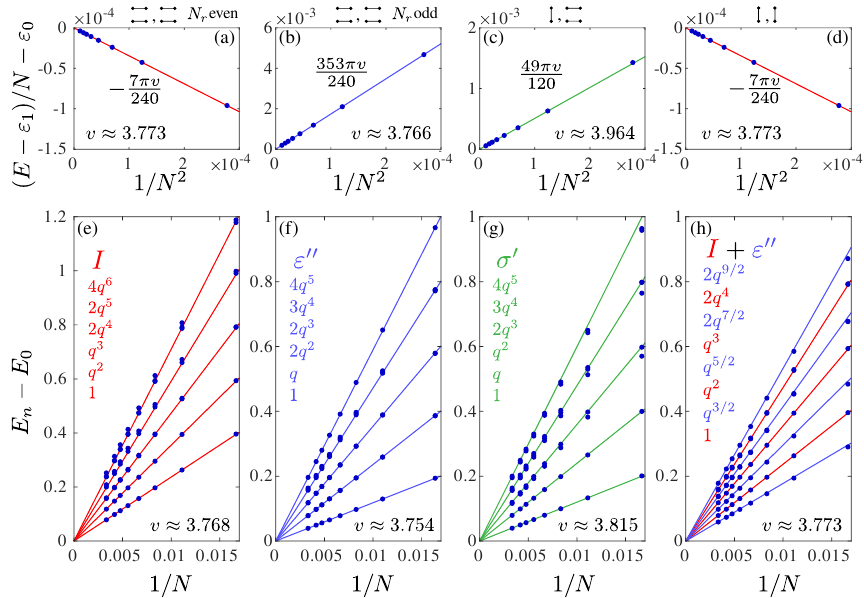
Figure 13: Finite-size scaling of the energy at the tricritical Ising point in the quan- tum dimer ladder with fixed boundary conditions. (a)-(d) Finite-size scaling of the universal term of the ground-state energy. (e)-(h) Finite-size scaling of the excitation energy with the inverse number of rungs. Blue dots are DMRG results. The velocities indicated in each panel are obtained by a numerical fit of the ground-state energy (a-d) or of the lowest excitation energies (e-h). Color lines are CFT predictions. The degeneracy of each level matches the CFT predictions, indicated as columns below the primary fields inside each